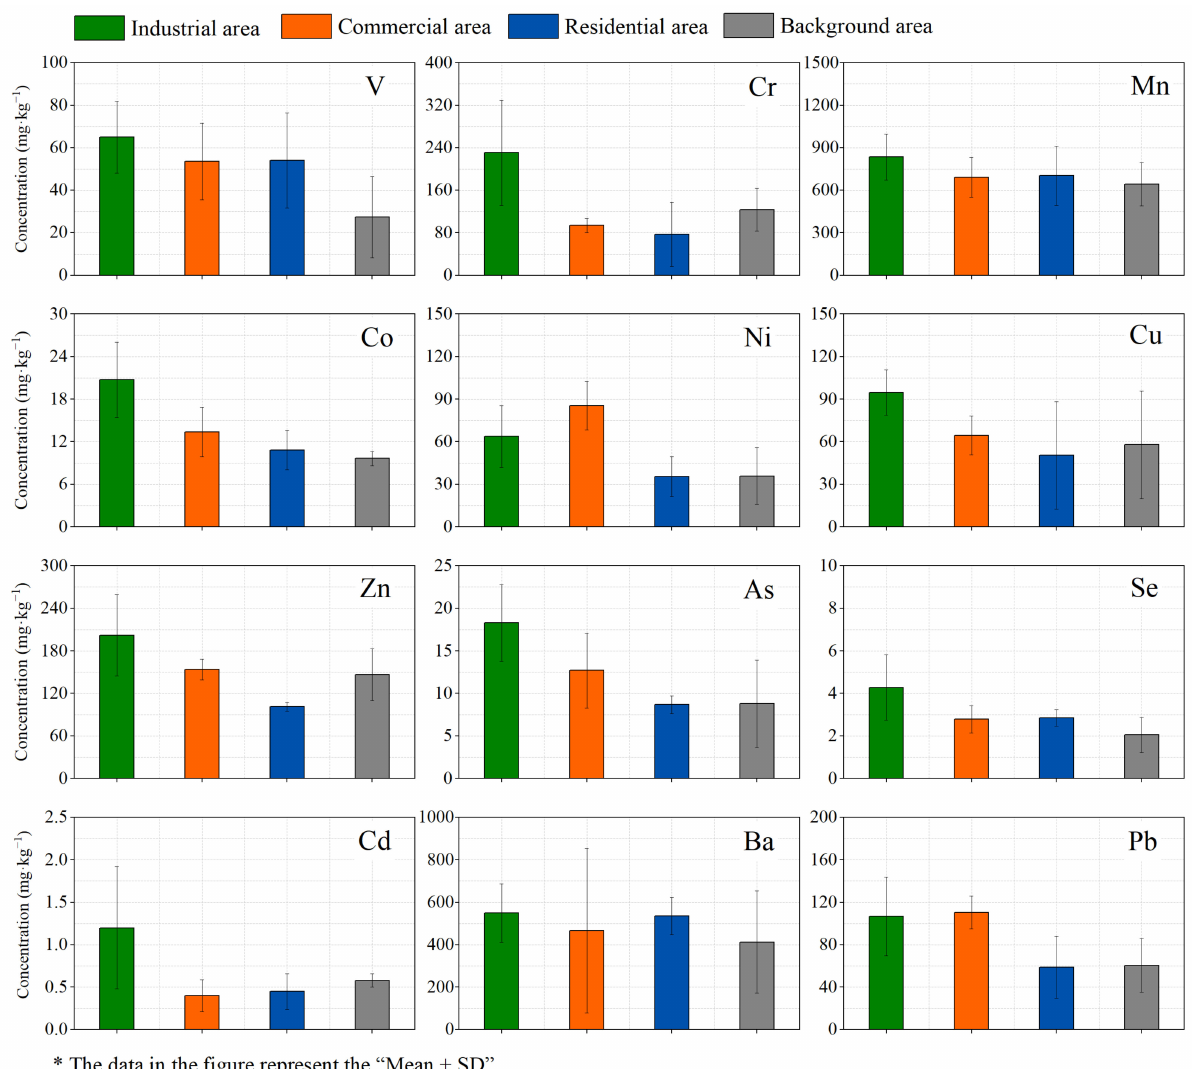
Figure 2. Concentration of PTEs in each